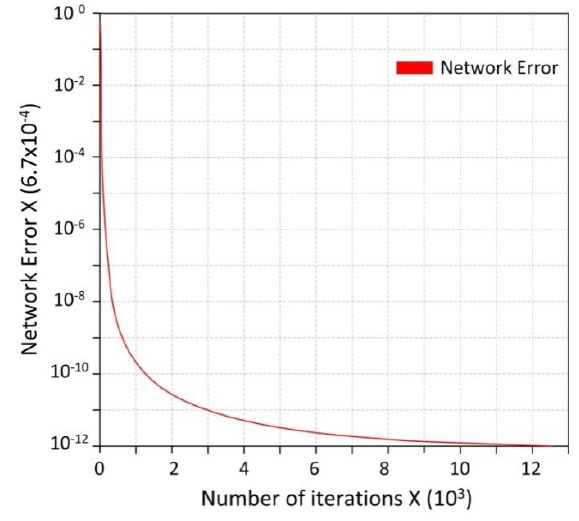
Figure 8. Evolution of the network errors.